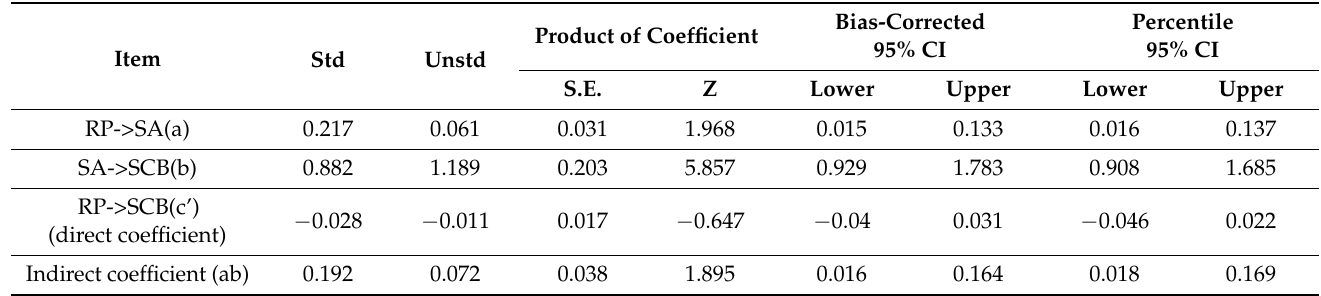
Table 10. The results of the mediation effect of M2.